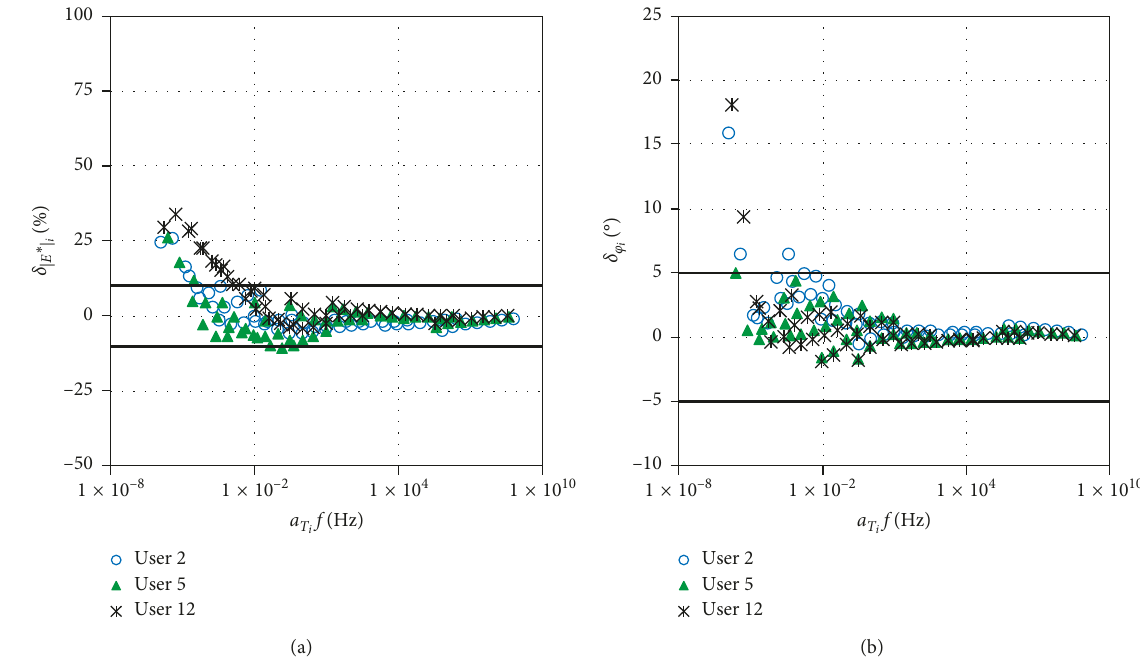
Figure 11: Errors between 2S2P1D simulations of the three most experienced users of the panel and experimental data for the bituminous E 9.53 ° C): relative error for (a) and absolute error for φ (b). Bold lines represent 10% and 5 ° limits for, respectively, relative mixture ( T ref (cid:31) | | and absolute errors. ∗